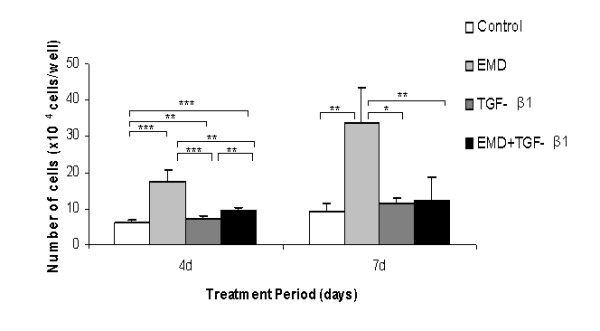
Effect of EMD, TGF-β1 and the combination of both factors on cell growth. All treatments showed an increase in cell proliferation. The EMD proliferation rate was higher than the positive control at days 4 and 7. *P < 0.05; **P < 0.01; ***P < 0.001.